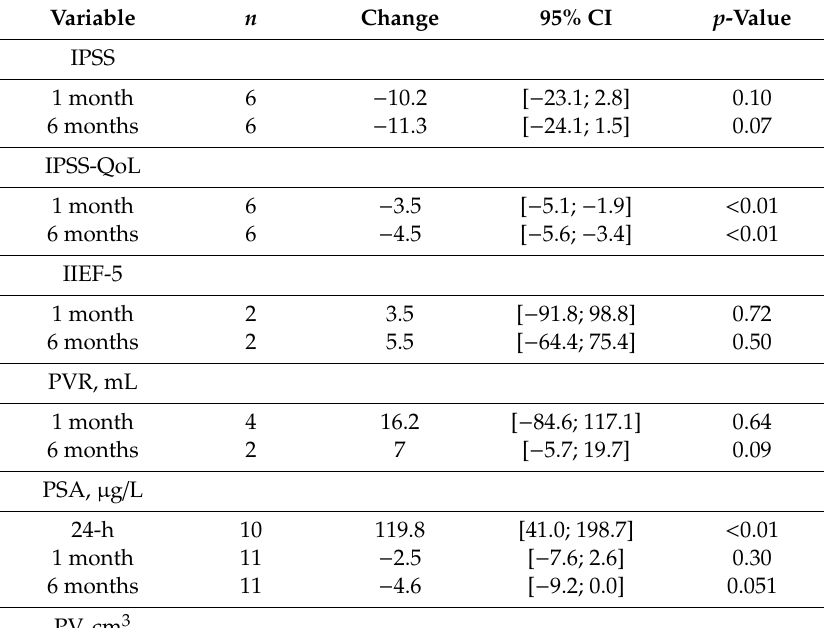
Table 2. Change from